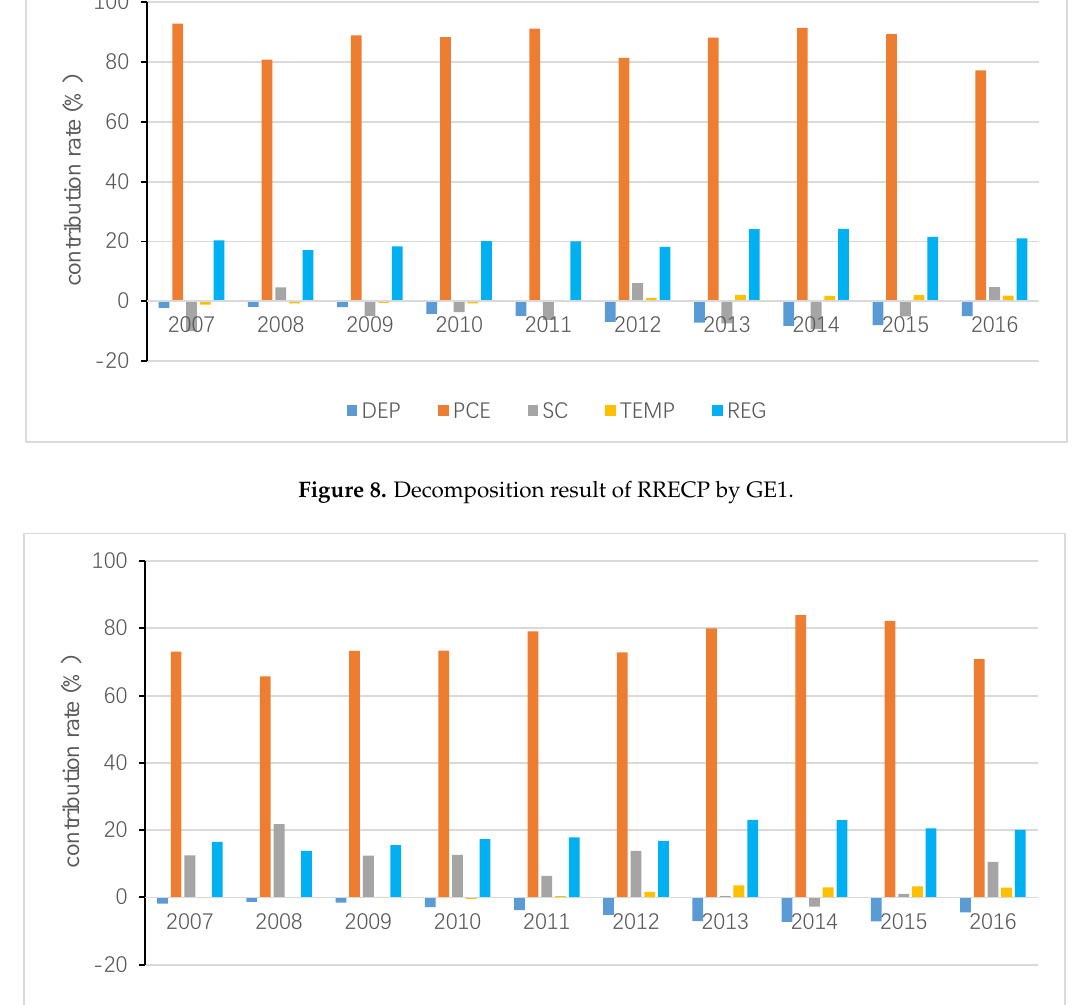
Figure 9. Decomposition result of RRECP by GE0.